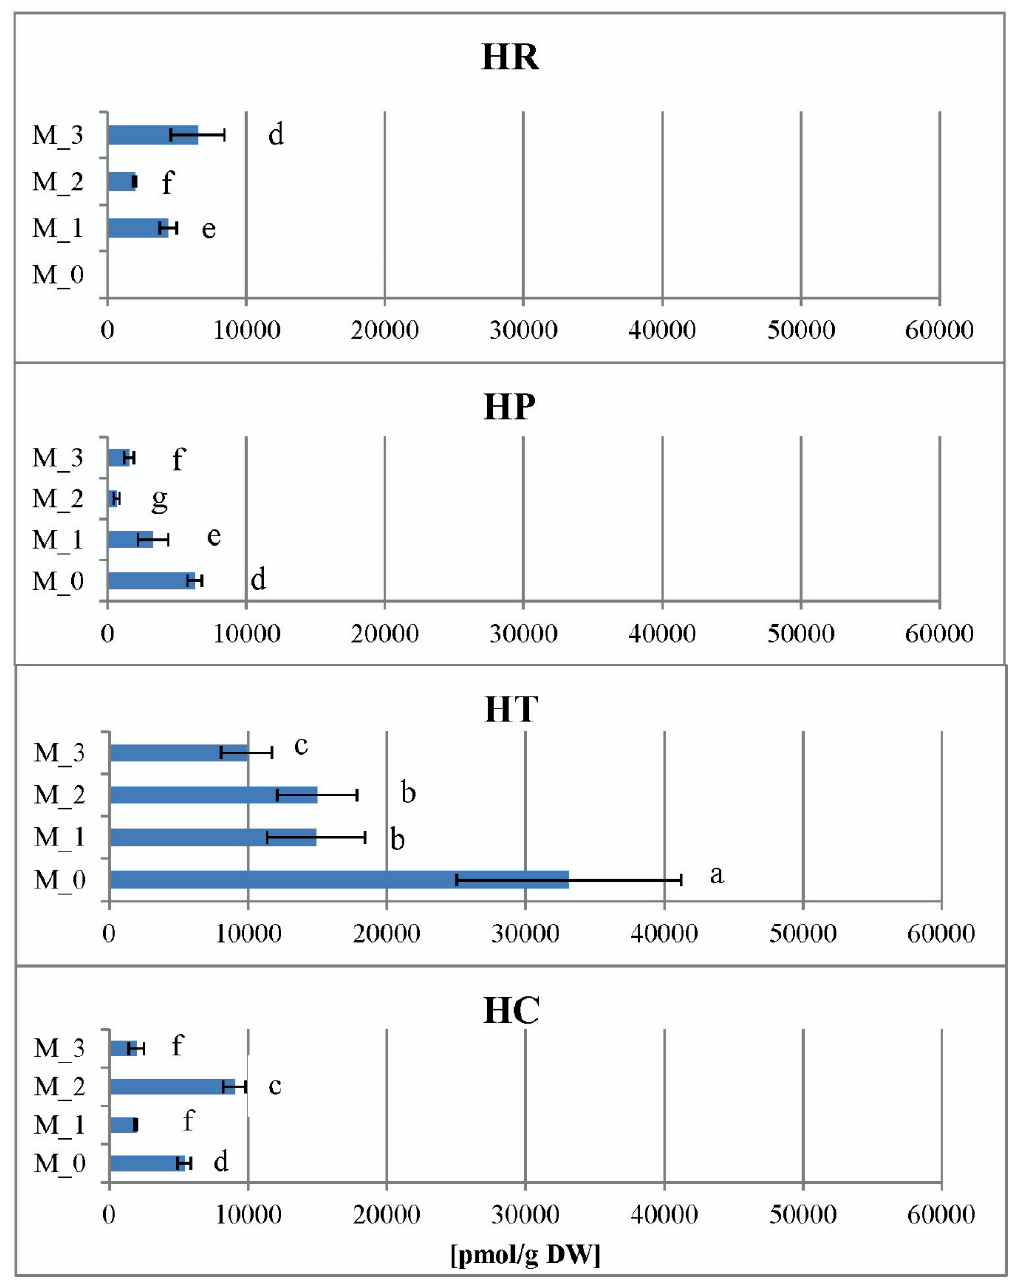
Figure 11. Phenylacetic acid (PAA) levels in the four Hypericum species in M_0—PGR-free, M_1—0.2 mg/L BA, M_2—0.2 mg/L BA + 0.1 mg/L IBA and M_3—0.1 mg/L BA + 0.2 mg/L IBA supplemented media. HR– H. richeri Vill., HP– H. perforatum L., HT– H. tetrapterum Fries. and HC– H. calycinum . Same letters indicate statistically non-significant and different letters indicate significantly significant differences in mean values when comparing the parameter between all samples.